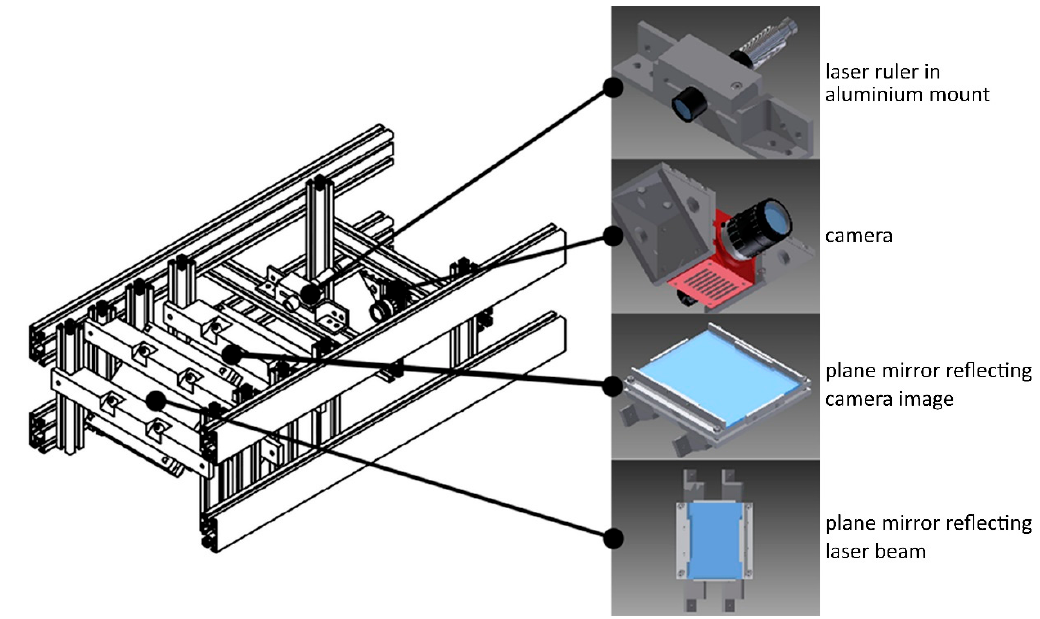
Figure 6. A construction of measurement head, the major components (laser, camera, mirrors) are mounted on a frame made from aluminum profiles.